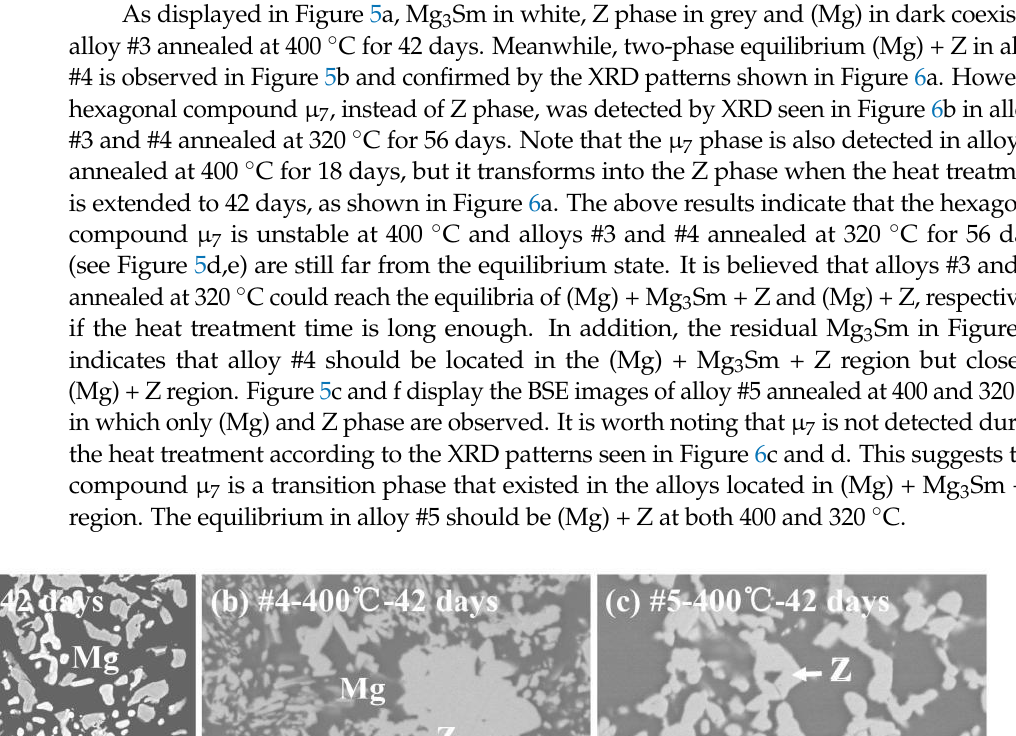
Figure 4. The XRD patterns of alloys #1 – #2 annealed at ( a ) 400 °C for 42 days and ( b ) 320 °C for 56 days.